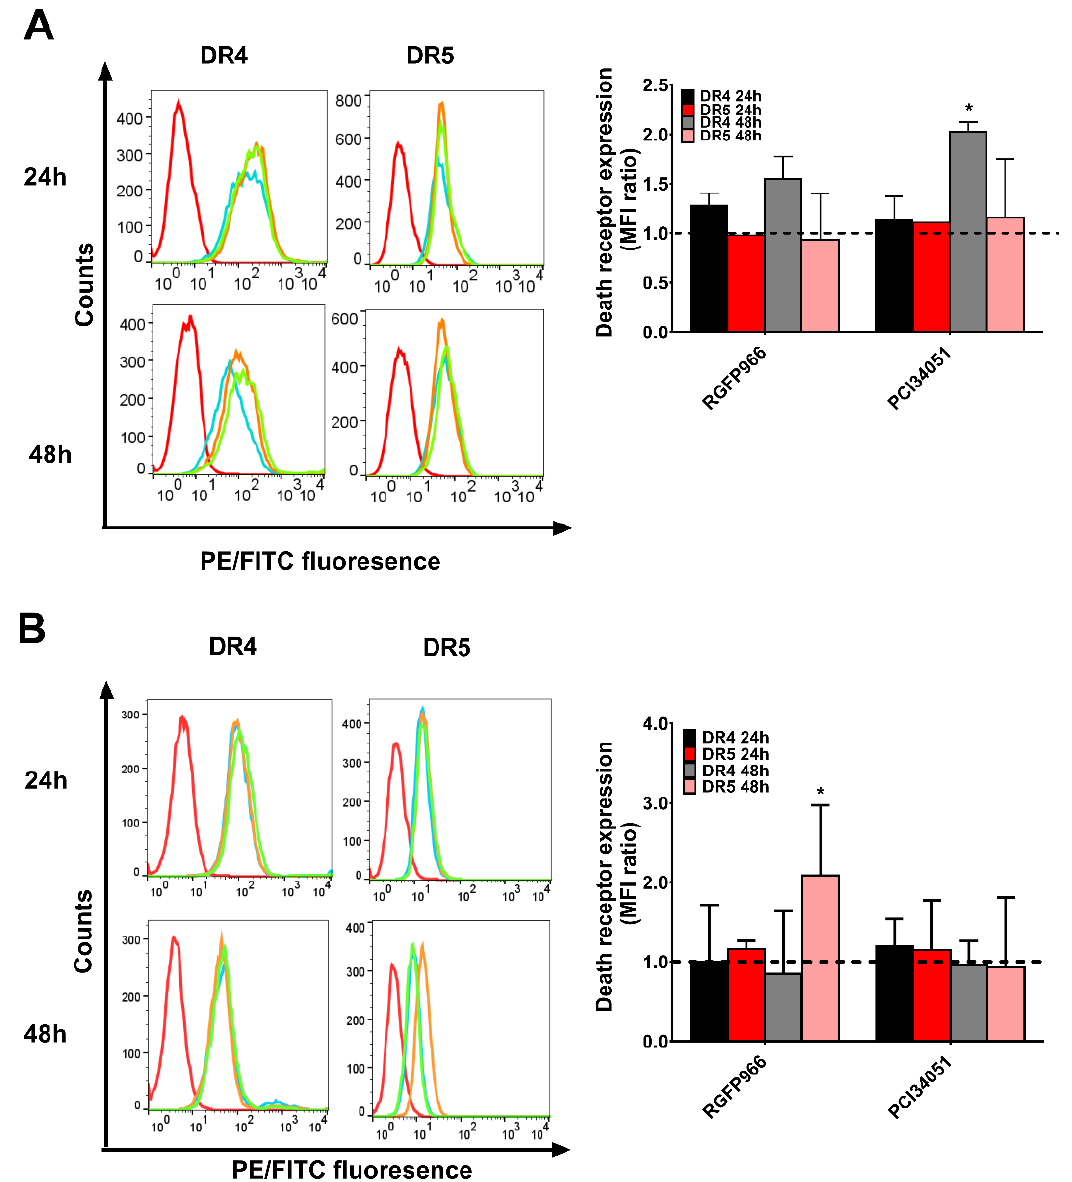
Figure 5. RGFP966 and PCI34051 changes expression of DR4 or DR5. DLD-1 ( A ) or WiDr ( B ) cells were incubated by RGFP966 or PCI34051 for 24 h or 48 h, and DR4 and DR5 expression were measured after incubation. The left panel shows the fluorescence shift and the right panel shows the geometric mean changes relative to untreated cells (dash line). On the left panel, red open lines show background signal of PE or FITC by adding only secondary antibodies to the cells. Blue open lines represent cells without HDAC inhibitor treatment, orange lines represent cells treated with 5 μ M RGFP966 and green open lines represent cells treated with 5 μ M PCI34051. p values were analyzed by one-way ANOVA in Turkey’s multiple comparison with Graphpad Prism version 7.0. * 0.01 ≤ p ≤ 0.05.